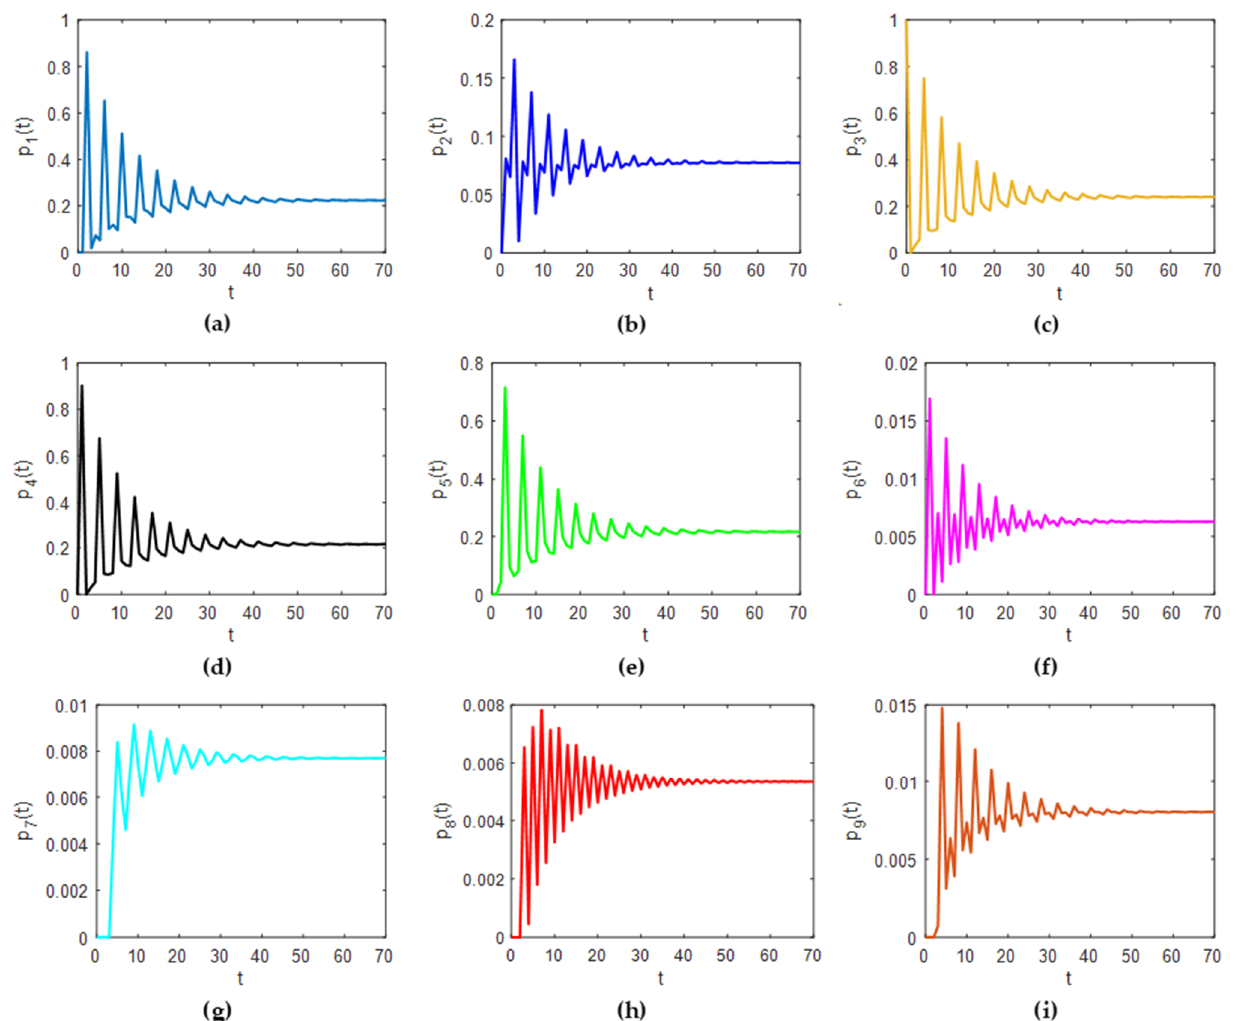
Figure 5. The course of changes in the probabilities of S 1 – S 9 states for the initial vector p 0 = [0,0,1,0,0,0,0,0,0]. ( a ) p 1 ( t ); ( b ) p 2 ( t ); ( c ) p 3 ( t ); ( d ) p 4 ( t ); ( e ) p 5 ( t ); ( f ) p 6 ( t ); ( g ) p 7 ( t ); ( h ) p 8 ( t ); ( i ) p 9 ( t